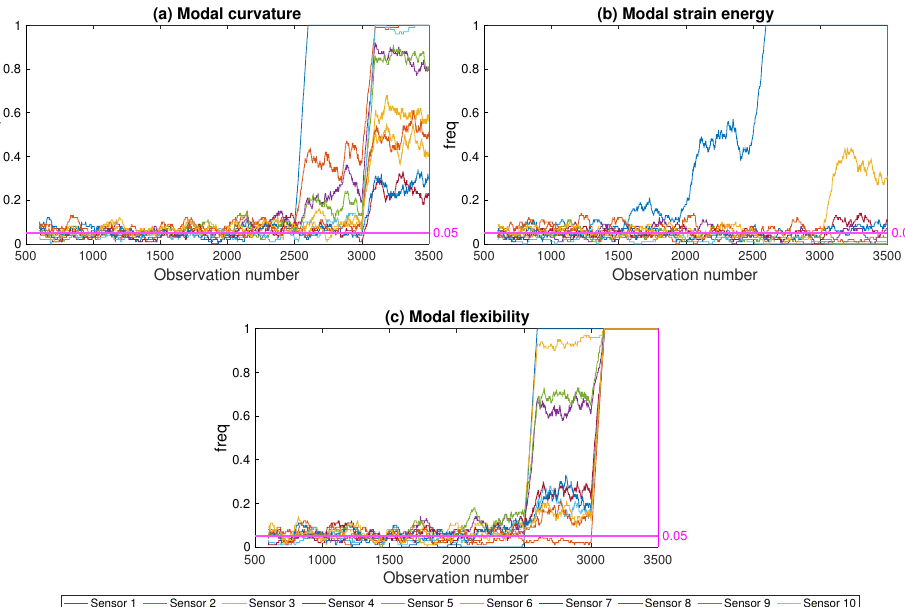
Figure 13. Effect of damage indicator; damage at the abutment; 5%